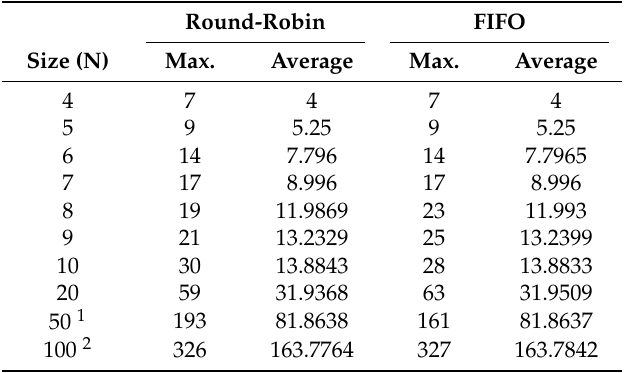
Table 1. Delay of the optimal scheduling (slots). Simulation time: 2000 time slots. Round-Robin FIFO Size (N) Max. Average Max. Average 4 7 4 7 4 5 9 5.25